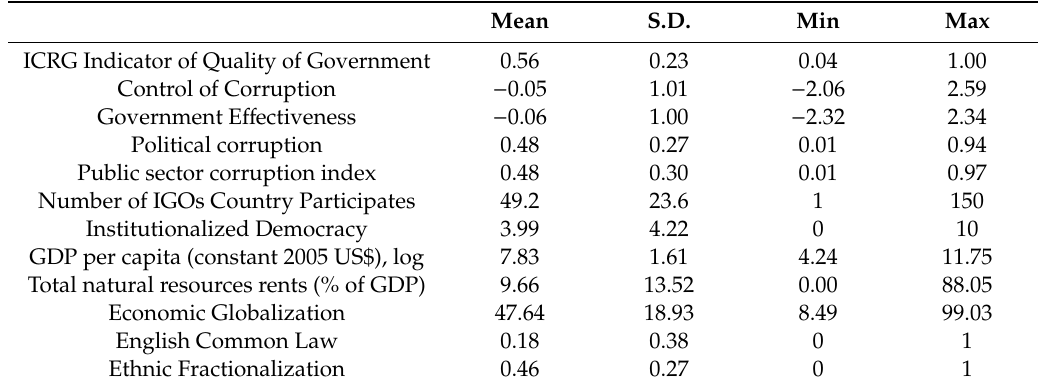
Table A2. Descriptive